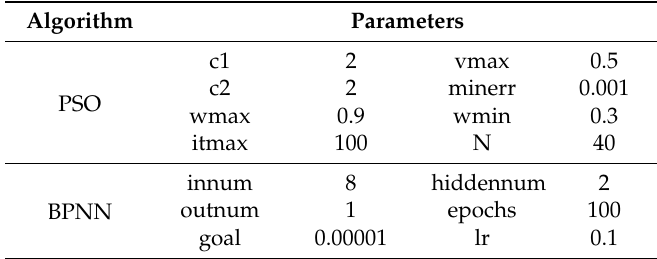
Table 2. Main parameters 1 settings of particule swarm optimization (PSO) and BPNN.